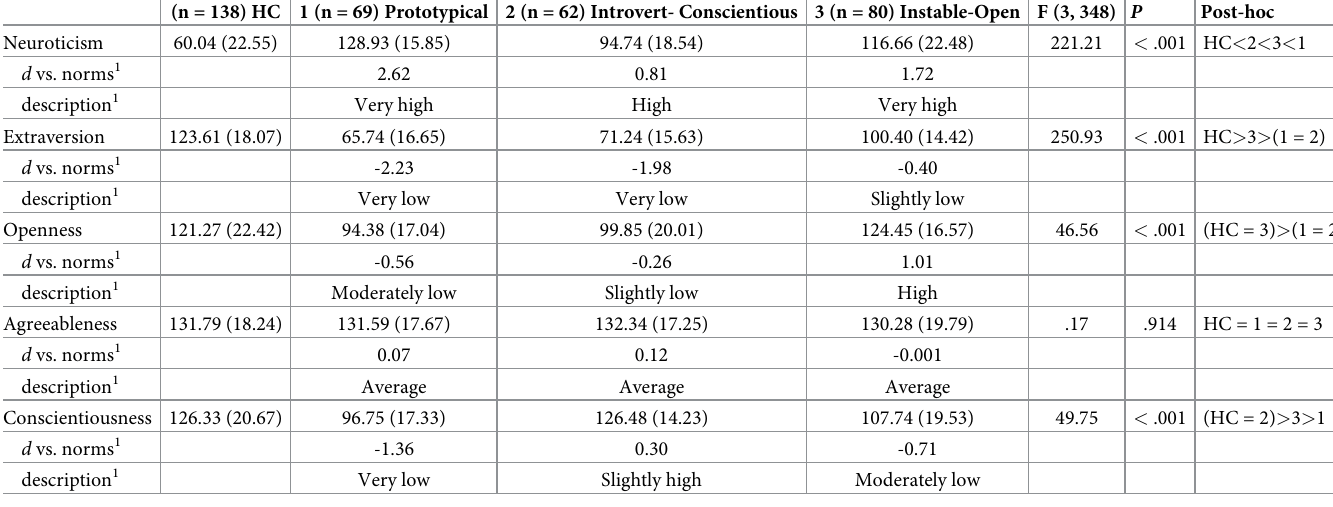
Table 4. Mean values (SD) and ANOVA results on the NEO-PI-R Big Five dimensions in three clusters of social anxiety disorder (SAD) patients compared with healthy controls (HC). (n = 138) HC 1 (n = 69) Prototypical 2 (n = 62) Introvert- Conscientious 3 (n = 80) Instable-Open F (3, 348) P